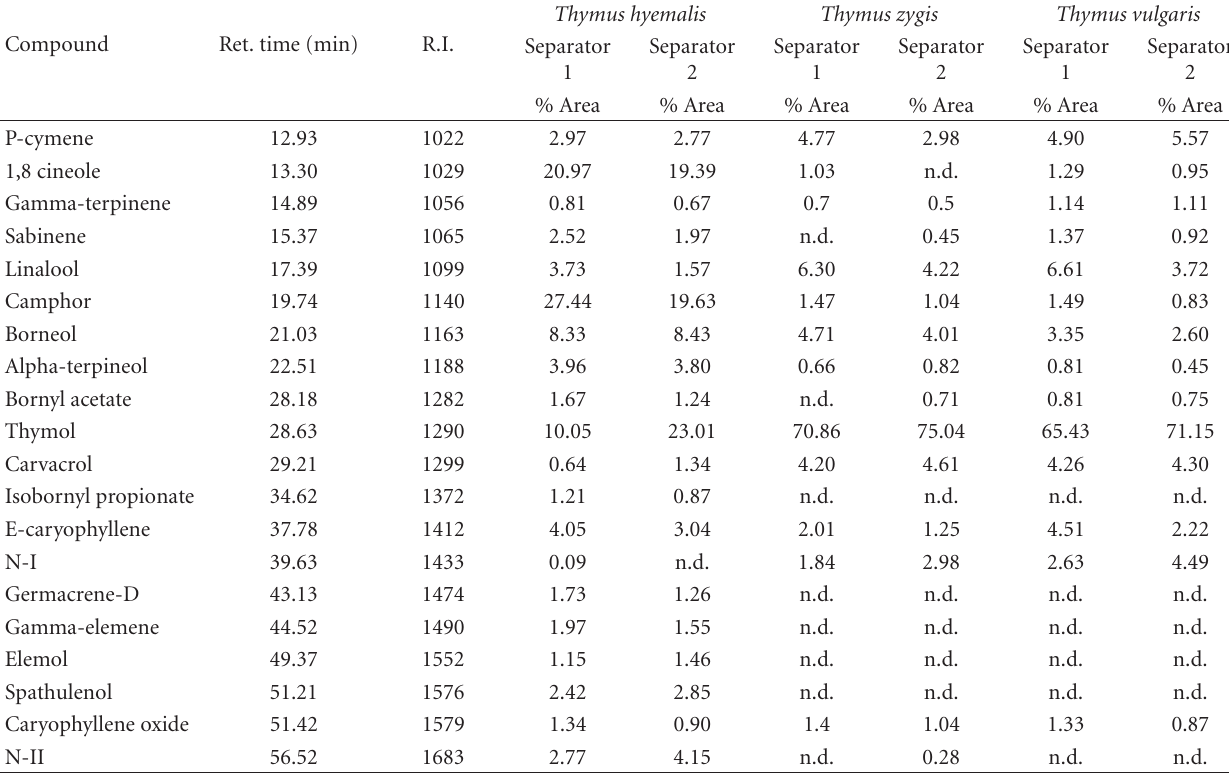
Table 1: Composition of the supercritical extracts of the three thyme varieties obtained in separators 1 and 2, and the contribution of each compound to the total chromatographic area. N-I: nonidentified compound; R.I.: linear retention index; n.d.: non